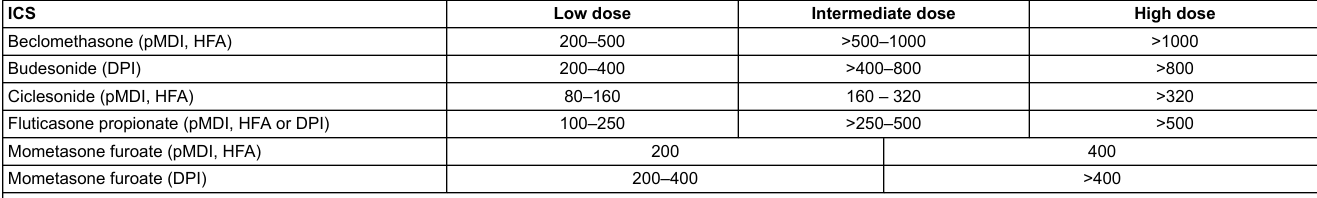
Table 3b: Total inhaled corticosteroid dose (μg/day) in patients older than 12 years. ICS Low dose Intermediate dose High